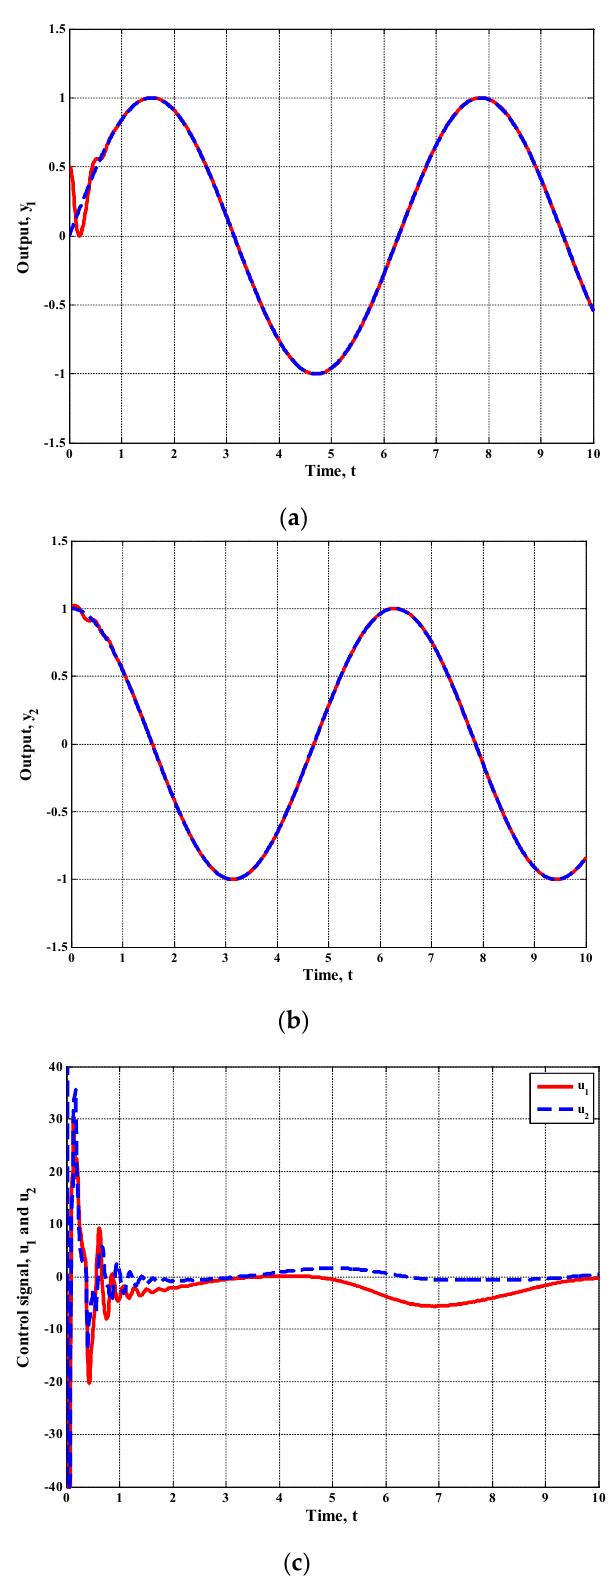
Figure 2. The output response of the hypothetical MIMO system controlled by ADRC based on LESO ( a ) output curve,